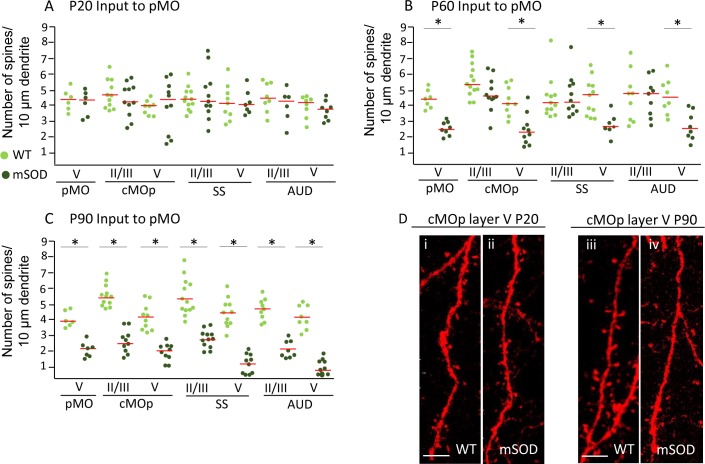
Pyramidal neurons projecting to pMO display simultaneous spines loss on basal dendrites during disease progression independently of misfolded SOD accumulation.(A) Spine density on pyramidal neurons projecting to primary at P20; each dot representing average spine density for one single neuron. Spine density was comparable in pyramidal neurons projecting to pMO in WT and mSOD mice. Detailed statistic provided in Supplementary file 3b. (B) Neurons projecting to primary motor cortex started to display spine loss at P60. Pyramidal neurons in layer V belonging to cMOp (4 ± 1 spines/10 μm in WT vs 2 ± 1 spines/10 μm in mSOD; p=0.0030), SS (4 ± 1 spines/10 μm in WT vs 3 ± 1 spines/10 μm in mSOD; p=0.0047) and AUD (5 ± 1 spines/10 μm in WT vs 3 ± 1 spines/10 μm in mSOD; p=0.0034) of mSOD mice displayed a significant decrease in spine density compared to their WT counterpart animals. Projecting neurons in layer II/III displayed a spine density comparable to WT. Detailed statistic provided in Supplementary file 3c. (C) Significant decrease in spine density affected the whole cortex when the latest stage was reached, at age of P90: cMOp layer II/III (WT 6 ± 1 spines/10 μm in WT vs 2 ± 1 spines/10 μm in mSOD, p=0.0001), layer V (4 ± 1 spines/10 μm in WT vs 2 ± 0.5 spines/10 μm in mSOD, p<0.0001); SS layer II/III (6 ± 1 spines/10 μm in WT vs 3 ± 1 spines/10 μm in mSOD, p<0.0001), layer V (4 ± 0.6 spines/10 μm in WT vs 1 ± 0.6 spines/10 μm in mSOD, p<0.0001); AUD layer II/III (5 ± 1 spines/10 μm in WT vs 2 ± 0.6 spines/10 μm in mSOD, p<0.0001), layer V (4 ± 1 spines/10 μm in WT vs 1 ± 0.5 spines/10 μm in mSOD, p<0.0001). Detailed statistic in Supplementary file 3d. (D i-ii) comparison of basal dendrite stretched between WT and mSOD at P20 in contralateral pMO layer V, scale bar 5 μm. D iii-iv: comparison of basal dendrite stretched between WT and mSOD at P90 in contralateral pMO layer V. Scale bar 5 μm. One-way ANOVA with Sidak correction.10.7554/eLife.36892.024Figure 7—source data 1.Detailed statistic concerning spine density on pyramidal neurons projecting to primary motor cortex during disease progression (P20, P60, P90).